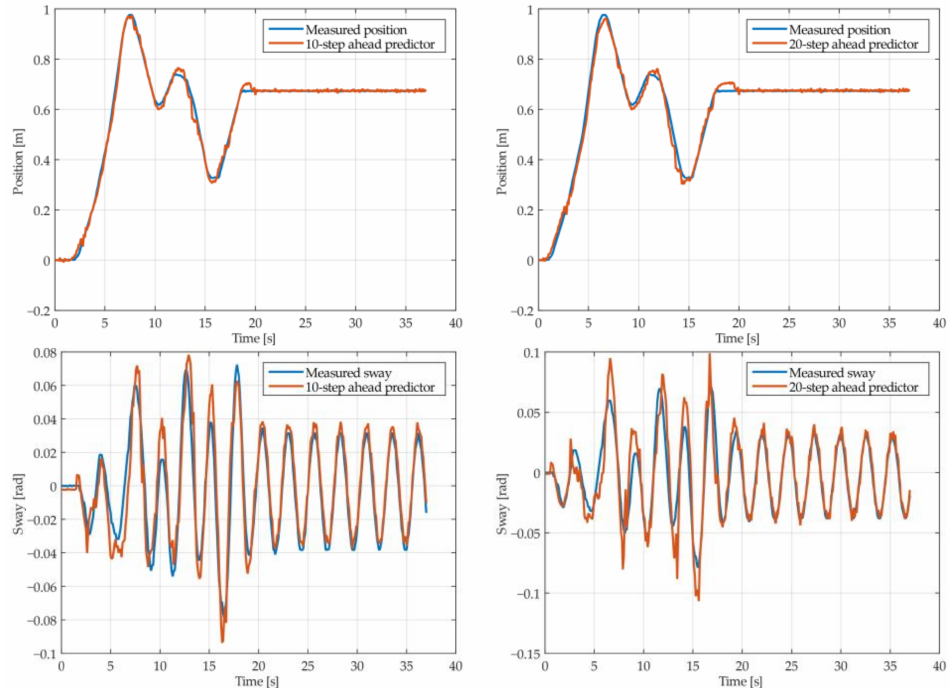
Figure 15. The 10- and 20-step ahead prediction with the MGGP model of the experimental crane position and payload sway with 1.3-meter rope and 40 kg payload